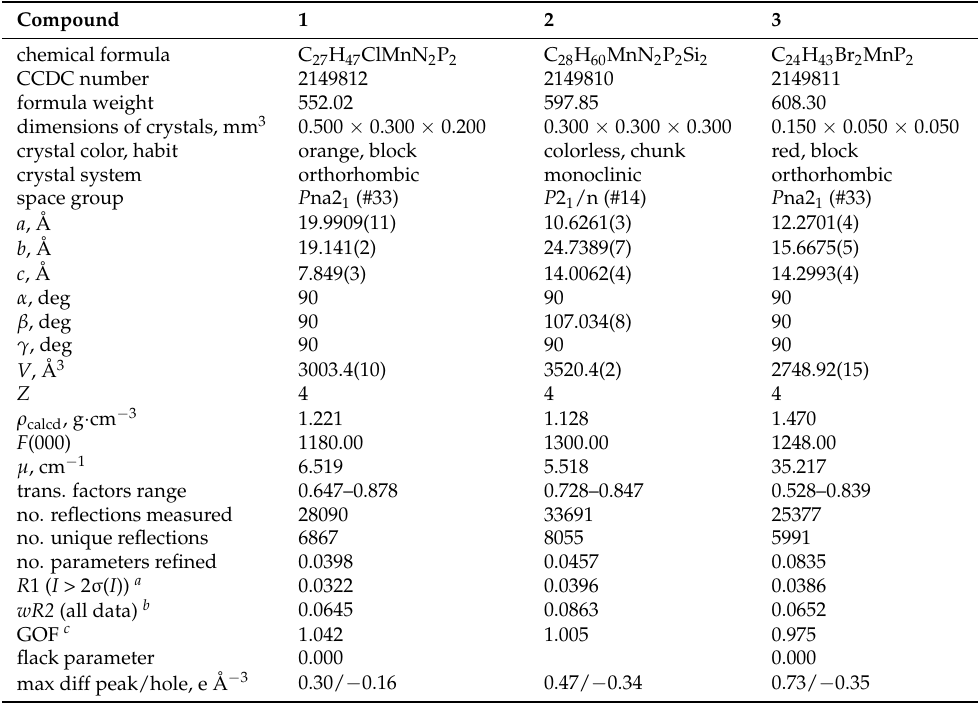
Table 6. X-ray crystallographic data for 1 – 3 .